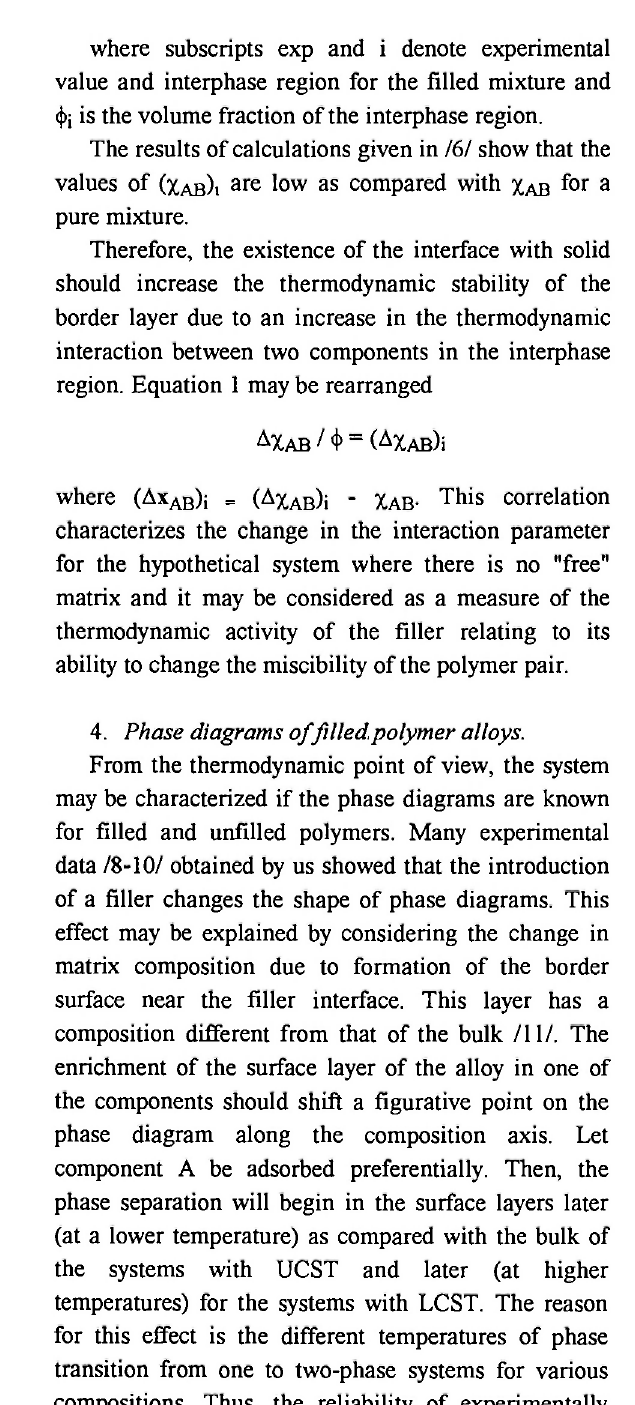
Fig. 2: Temperatures of phase separation of PVA- PBMA (0.7:0.3) alloy on nonsilanized (1, 2, 3) and silanized (4) glass surface as a function of film